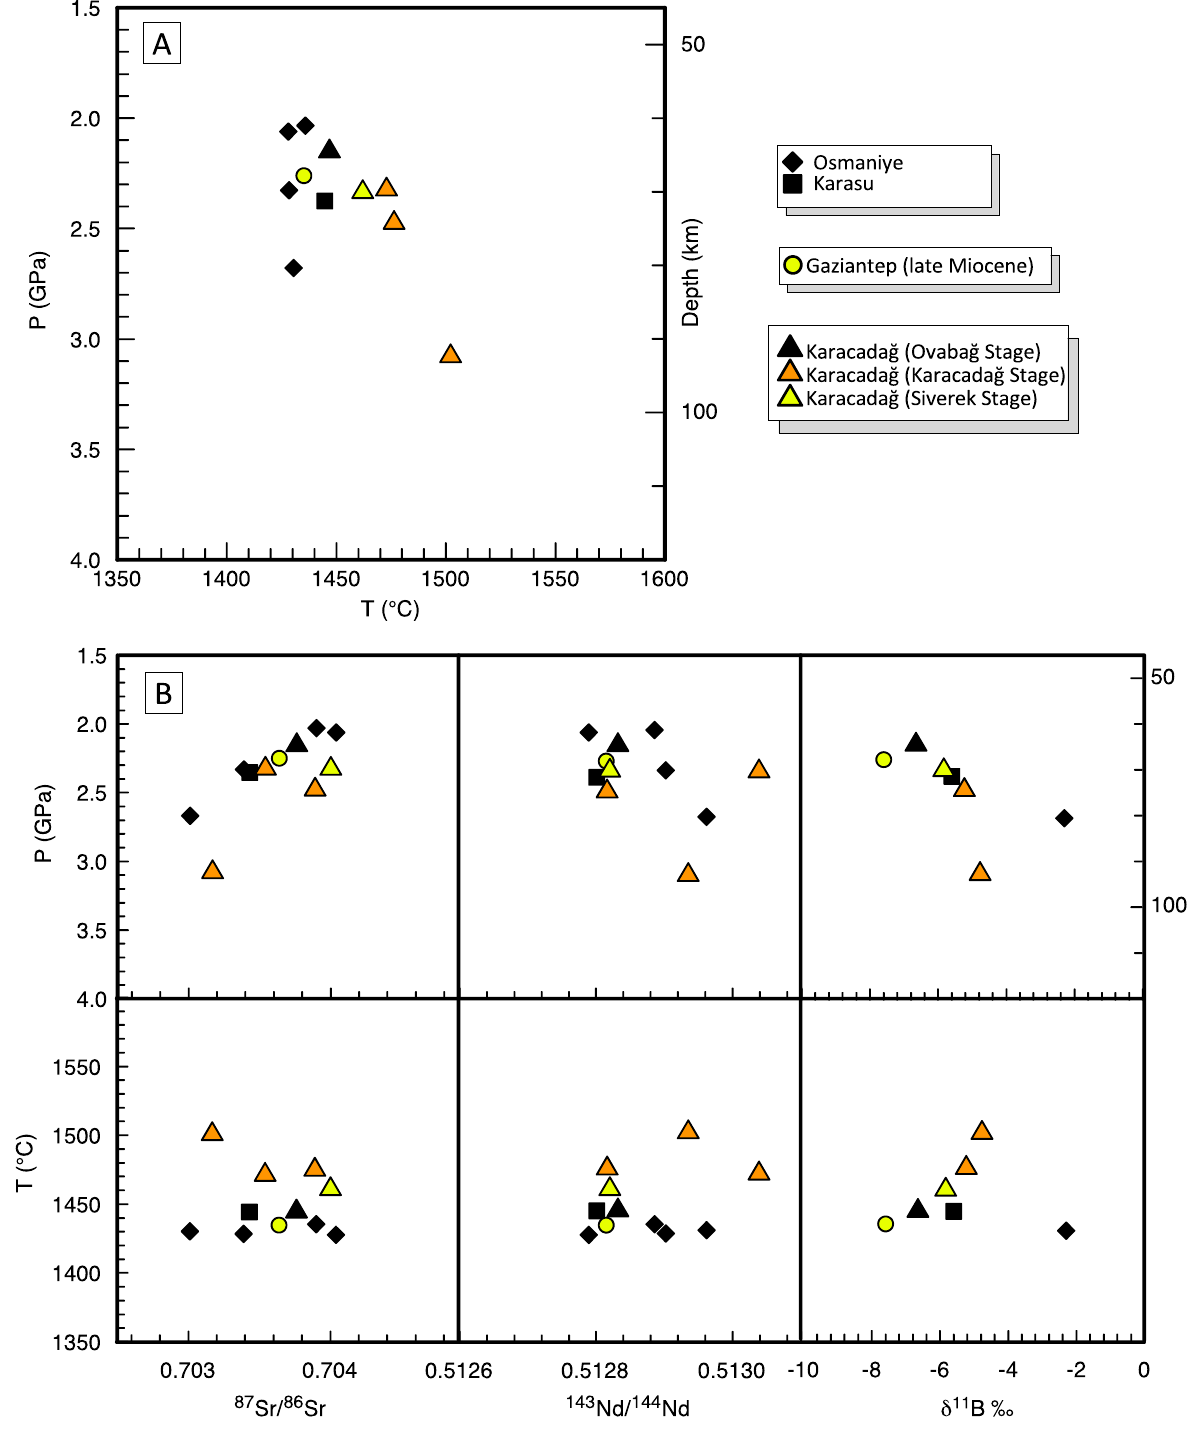
Figure 6. Covariations of intensive parameters and isotope compositions for samples with SiO 2 wt% < 50. ( A ) Temperatures vs. pressures of magma segregation calculated for selected primitive basaltic rocks. ( B ) P and T vs. 87 Sr/ 86 Sr, 143 Nd/ 144 Nd, and δ 11 B